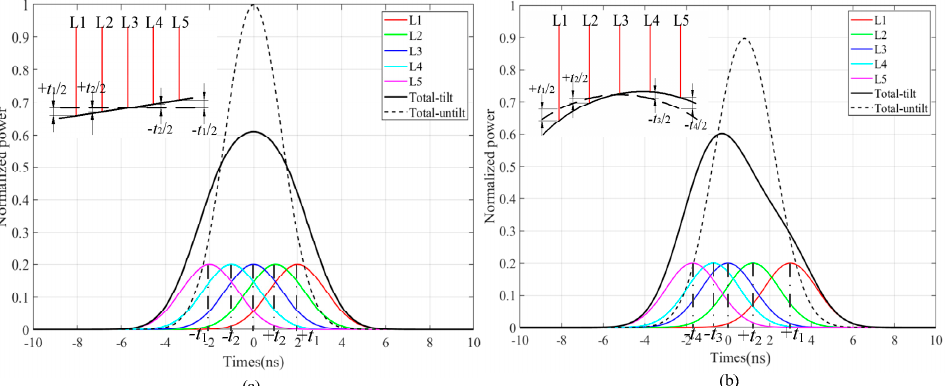
Figure 16. The echoes and the superimposed echo of five sub-rays of different targets. ( a ) A plane and an inclined plane; ( b ) A sphere and an inclined sphere.